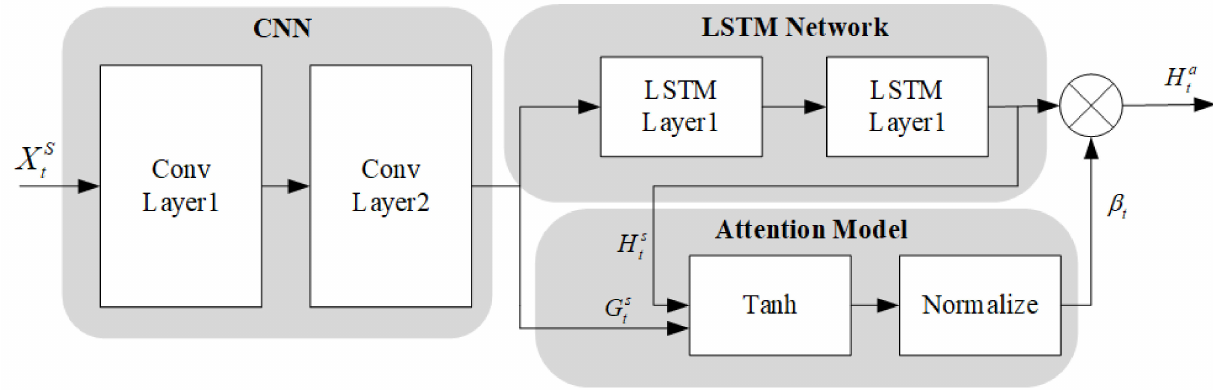
Figure 4. The ConvLSTM structure of this